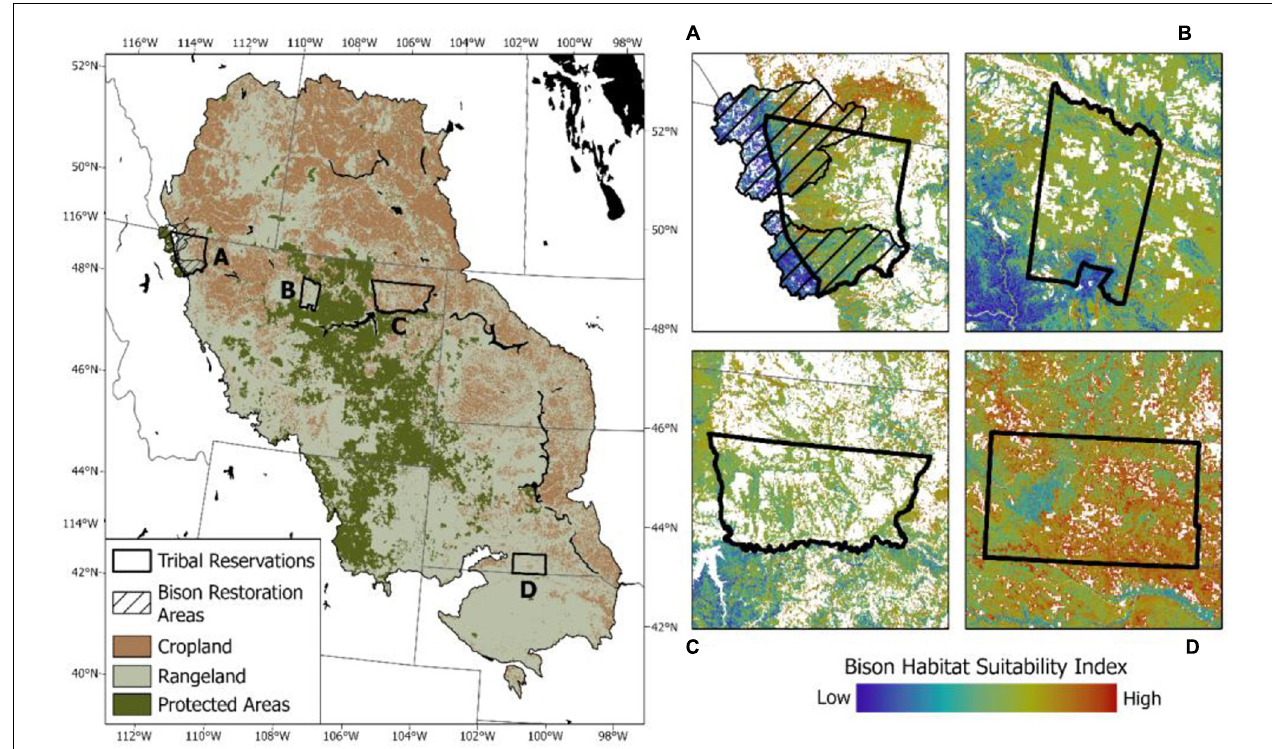
FIGURE 3 | Northern great plains study area based on Commission for Environmental Cooperation (CEC) terrestrial ecoregions—Northwestern Great Plains, Northwestern Glaciated Plains, and the Nebraska Sand Hills. Also included are the northern and southern bison reintroduction areas which extend west of Blackfeet Reservation in the northwest part of the ecoregion (hatched, A ). Full map shows the extent of cropland (World Wildlife Fund, 2018), rangelands (World Wildlife Fund, 2018), and Protected Areas in IUCN categories I-V (Environment and Climate Change Canada [ECCC], 2020; U. S. Geological Survey [USGS] Gap Analysis Project [GAP], 2020). Individual maps show bison habitat suitability index (HSI) in the target Tribal Reservations: (A) Blackfeet Reservation (scale 1:2,000,000); (B) Fort Belknap Reservation (scale 1:1,250,000); (C) Fort Peck Reservation (scale 1:2,250,000); and (D) Rosebud Reservation (scale 1:1,250,000). HSI details in Supplementary Materials (3)